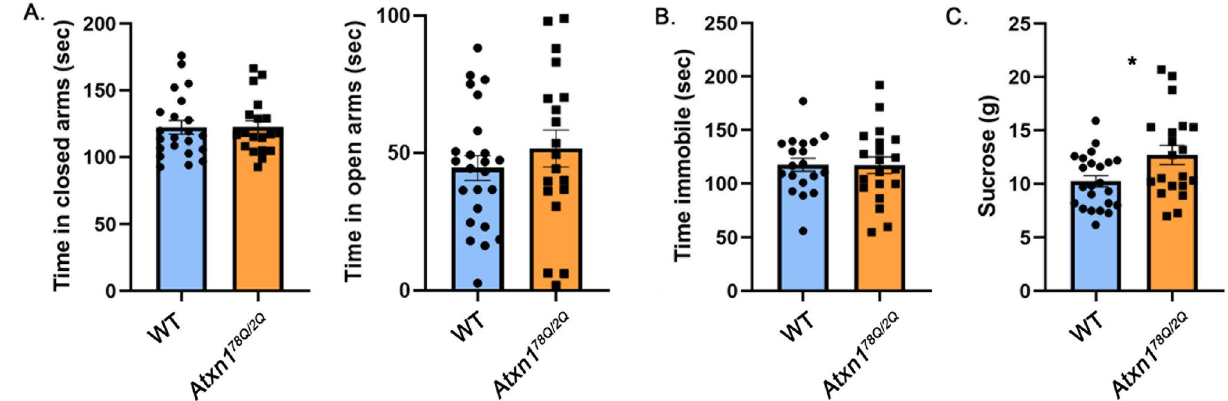
Figure 2. Atxn1 78/2Q mice exhibit increased sucrose consumption. 8–10 weeks old Atxn1 78Q/2Q mice and their wild-type littermates were tested on the Elevated Plus Maze, Forced Swim Test and Sucrose preference test. ( A ) Time in closed and open arms. ( B ) Time spent immobile. ( C ) Amount of sucrose consumed. * indicates P < 0.05 using unpaired, two-tailed t test, data are presented as mean ±